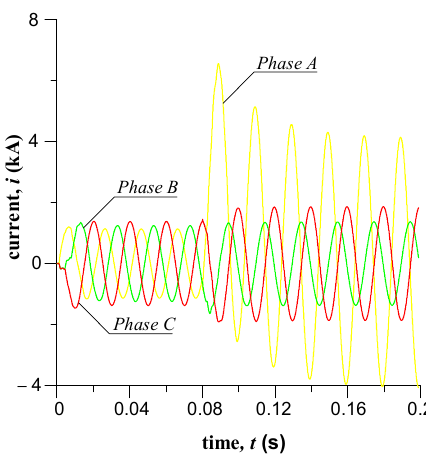
Figure 9. The phase current waveforms at the line’s end. Analyzing the current waveforms at the end of the line, we see that the steady-state amplitude of the C phase current during normal operation is 1.7 kA, while following a phase A short-circuit fault, the C phase current amplitude increases to 1.9 kA, and the B phase current amplitude practically does not change. The current waveforms across the load branches are nearly the same as the current waveforms at the line’s end, cf. Figures 9 and 10.